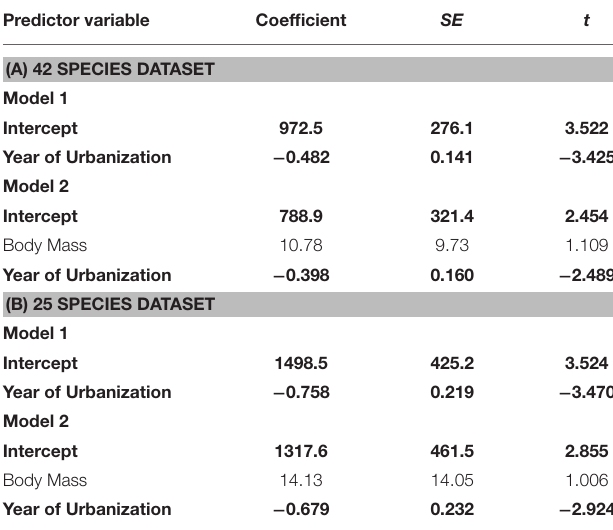
TABLE 2 | Parameter estimates from models with 1 AICc < 2, explaining variation in degree of tolerance among birds.